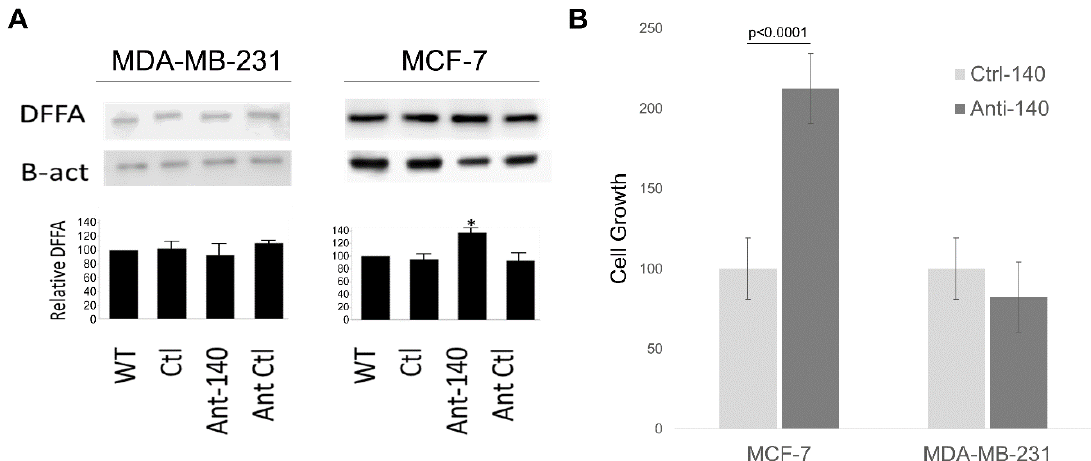
Figure 6. Depletion of DFFA protein expression and the effect of miR-140-3p on cellular growth. ( A ) Representative blots for DFFA and β-actin (loading control) are shown (n = 3). The miRNA is able to bind and regulate the DFFA gene in MCF-7, but not in MDA-MB-231 due the presence of an A-to-I edit. WT, wild type; Ctl, empty lipo transfection; Ant-140, miR-140 antagomir; Ant-Ctl, random antagomir. ( B ) Cell growth assay examining effects of transfecting a miR-140 inhibitor in both cell lines. Five microscopic fields randomly chosen from each assay were counted individually, and the statistical significance between treatment and control determined by t -test.